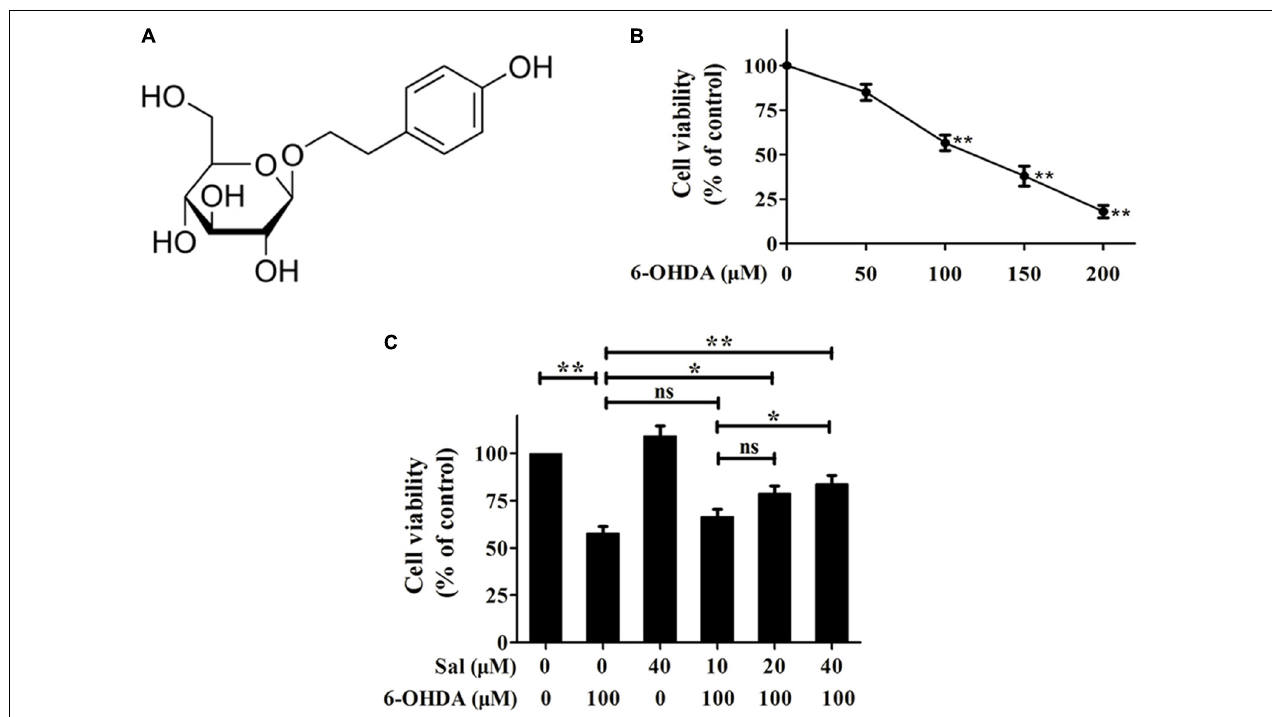
FIGURE 1 | Protective effects of Sal against 6-OHDA induced cytotoxicity in SH-SY5Y cells. (A) Sal is glucoside of tyrosol (p-hydroxyphenethyl- β -D-glucoside). (B) 6-OHDA treatment reduces cell viability of SH-SY5Y cells. SH-SY5Y cells were incubated with various concentrations (50, 100, 150, and 200 µ M) of 6-OHDA for 24 h then the cell viability was assayed using MTT. (C) Sal attenuates 6-OHDA-induced reduction in cellular viability. Cells were pretreated with various concentrations (10, 20, and 40 µ M) of Sal for 24 h after which 6-OHDA (100 µ M) was added for an additional 24 h. The cell viability was measured using MTT. Data are shown as the mean ± SEM. Statistical significance was analyzed by one-way analysis of variance (ANOVA). A two-tailed Student’s t -test was performed for comparisons between two groups. Each experiment was repeated three times independently. ∗ P < 0.05; ∗∗ P < 0.01, ns: no